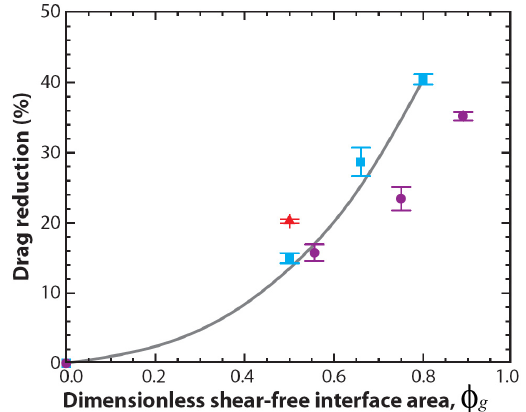
Figure 23. Average drag reduction as a function of dimensionless shear-free area, gas fraction. Measurements for 30 µ m wide microridges spaced 30 µ m apart (red triangles), 20 µ m wide microridges spaced 20 µ m apart (blue squares), and 30 µ m square microposts spaced 30 µ m apart (purple circles). Numerical results for 20 µ m wide microridges spaced 20 µ m apart (gray line). From Rothstein